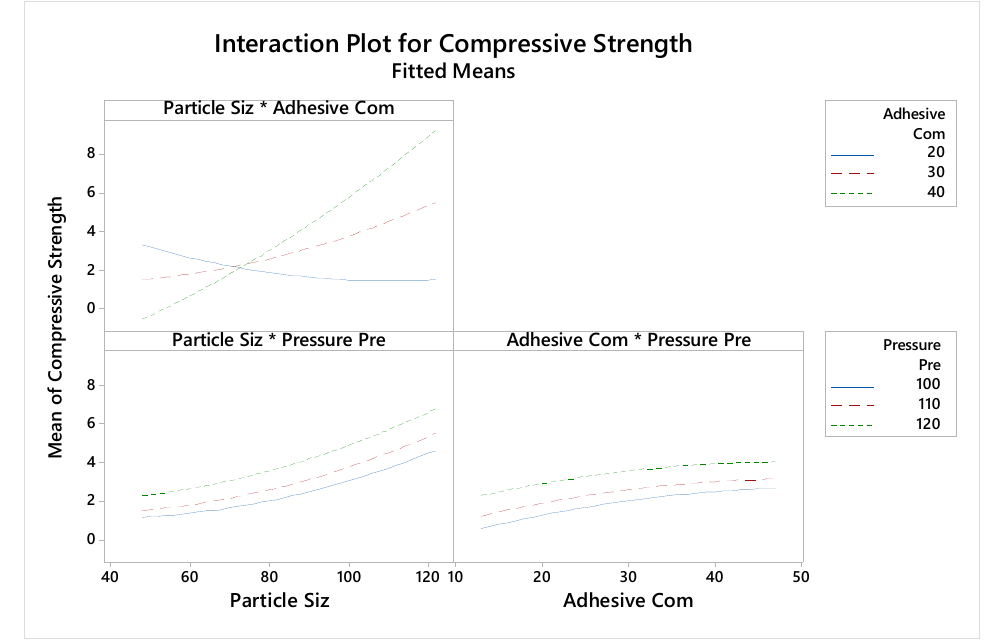
Figure 7. Two-factor interaction effect of process conditions on the compressive strength.